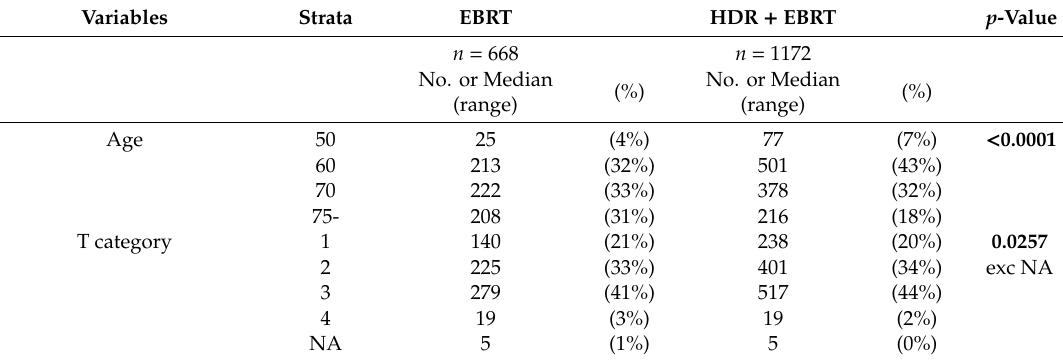
Table 5. Comparison of background between EBRT and HDR + EBRT